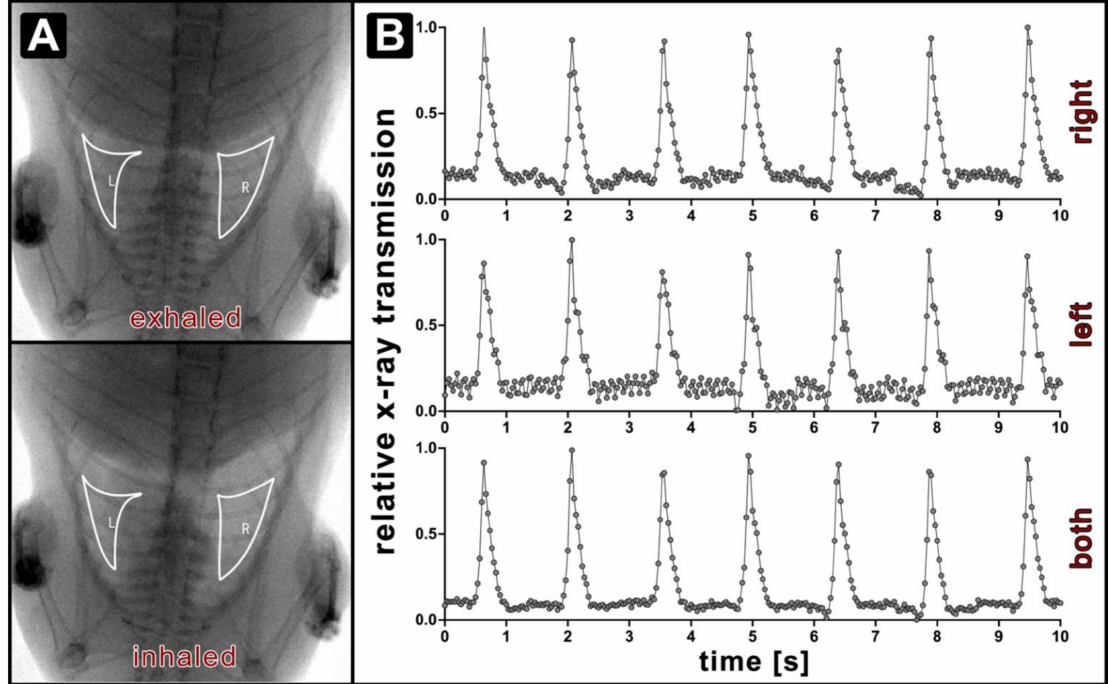
Figure 2. Exemplary XLF measurement of a wt mouse at 38 days from birth displaying representative images of exhaled and inhaled states as seen in the planar X-ray projection video with right (R) and left lung (L) regions defined ( A ) and the corresponding calculated relative X-ray transmission traces obtained from right, left, and both lungs averaged ( B